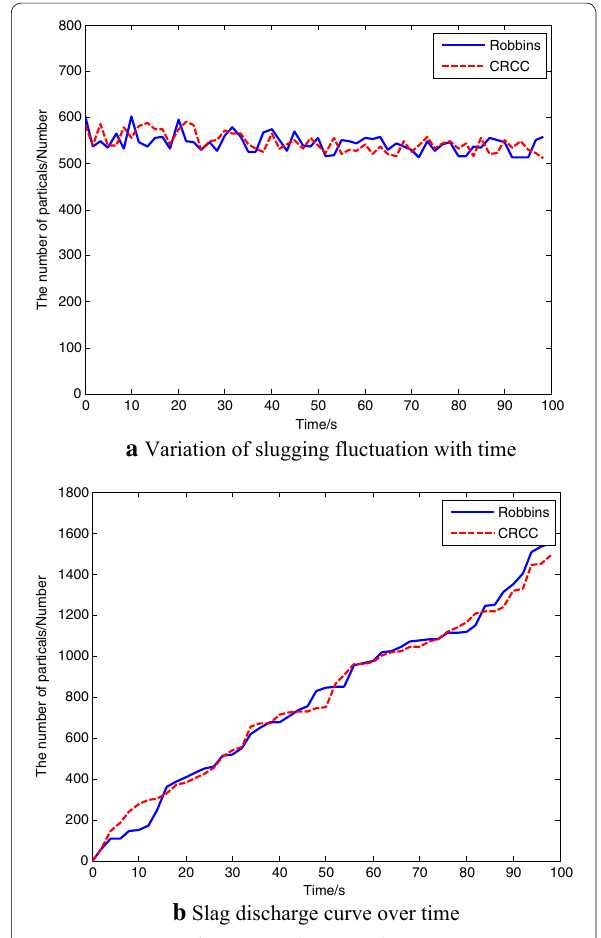
Figure 14 Discrete element simulation results